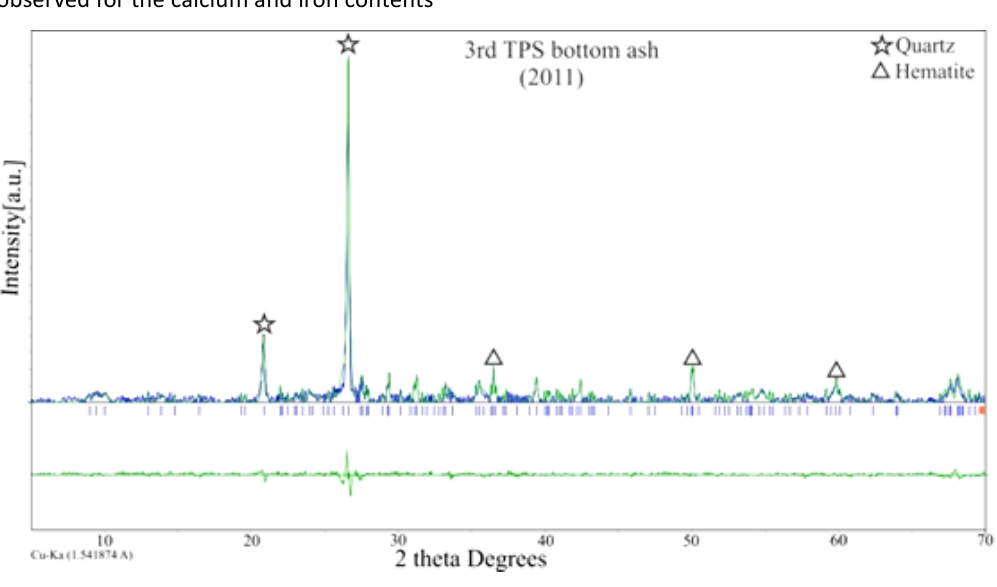
Fig. 2. XRD pattern of the ash collected in